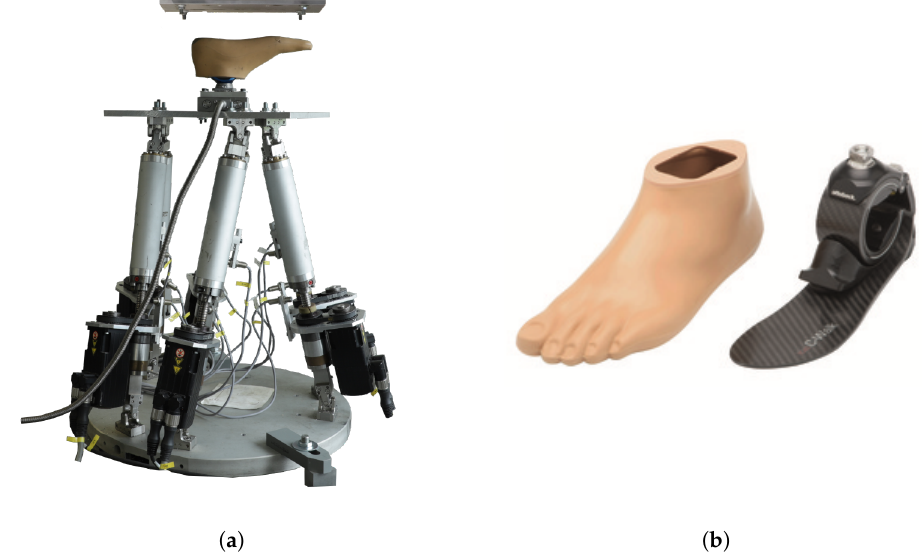
Figure 6. The transfer system and the experimental part are depicted. ( a ) The experimental setup consists of the prosthetic foot, the FTS, and the Stewart Platform. ( b ) The C-Walk foot 1C40 by Ottobock with silicone cosmesis (© by Ottobock).